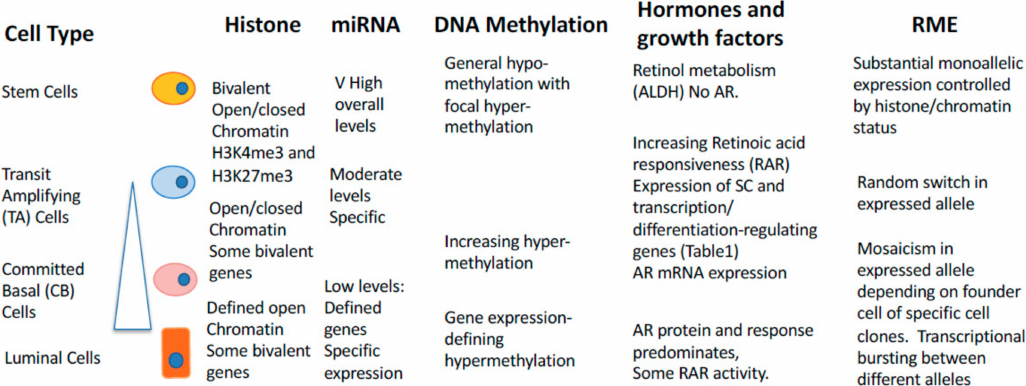
Figure 6. An integrated model of epigenetic control in prostate epithelium. The di ff erentiation of prostate epithelium is controlled by multiple epigenetic influences. Between the defining self-renewal upon SC asymmetric cell division and the terminal di ff erentiation into a luminal cell, there exists a continuum of di ff erentiation (see shaded triangle). TA and CB cells are recognizable intermediates but exist within this continuum. As cells become more di ff erentiated, the reversibility of the procedure becomes less likely (see Figure 1B). Details of individual controls are given in the